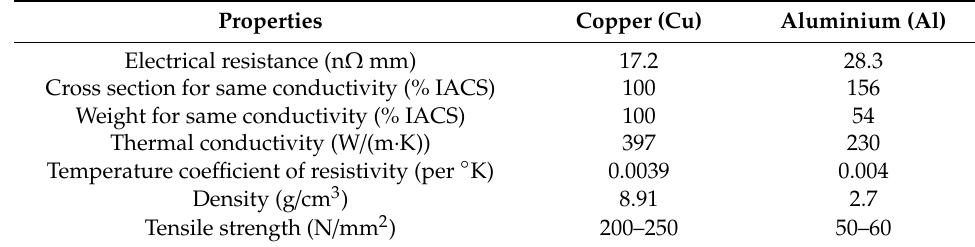
Table 1. A comparison of copper and aluminium properties [9,32]. IACS: International Annealed Copper Standard.